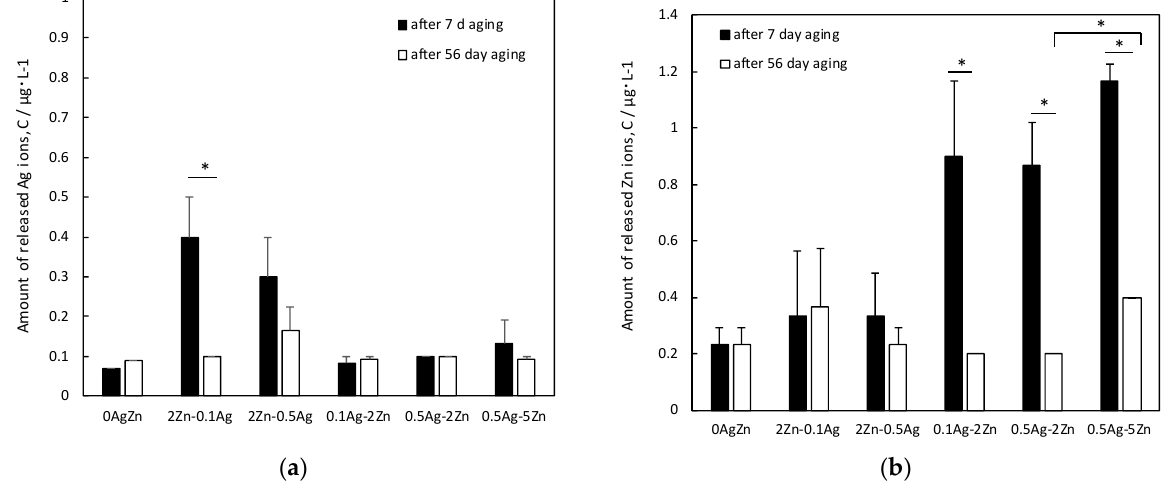
Figure 8. Amounts of ( a ) Ag ions and ( b ) Zn ions released from the oxide layer into physiological saline (* statistically significant difference, p < 0.05). Measurements were performed on five equally conditioned specimens ( n = 5).